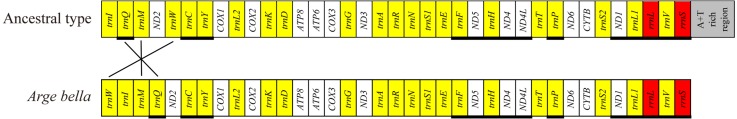
Mitochondrial genome organisation of A. bella.Mitochondrial genome organisation of insects in general (above) and A. bella (below). Genes are transcribed from left to right, except for those underlined. PCGs are marked by white, the A + T rich region by grey, rRNA genes by red, and tRNA genes by yellow and single-letter amino acid codes. Gene rearrangements are shown with connecting lines that indicate the translocation of trnW from the trnW-trnC-trnY cluster to a position downstream of trnI and the swapped position of trnM and trnQ.